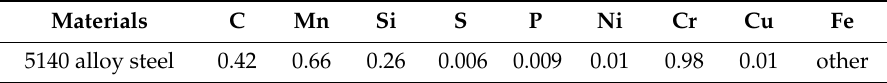
Table 1. The chemical composition of the 5140 alloy steel (wt. %).